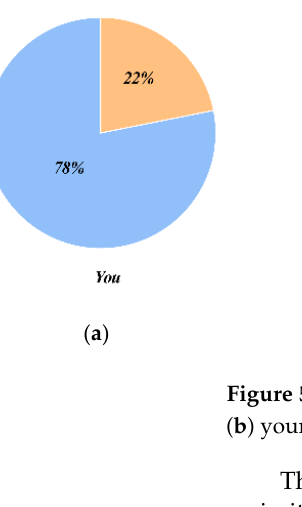
Figure 4. Participants’ preferred choice in different conditions.